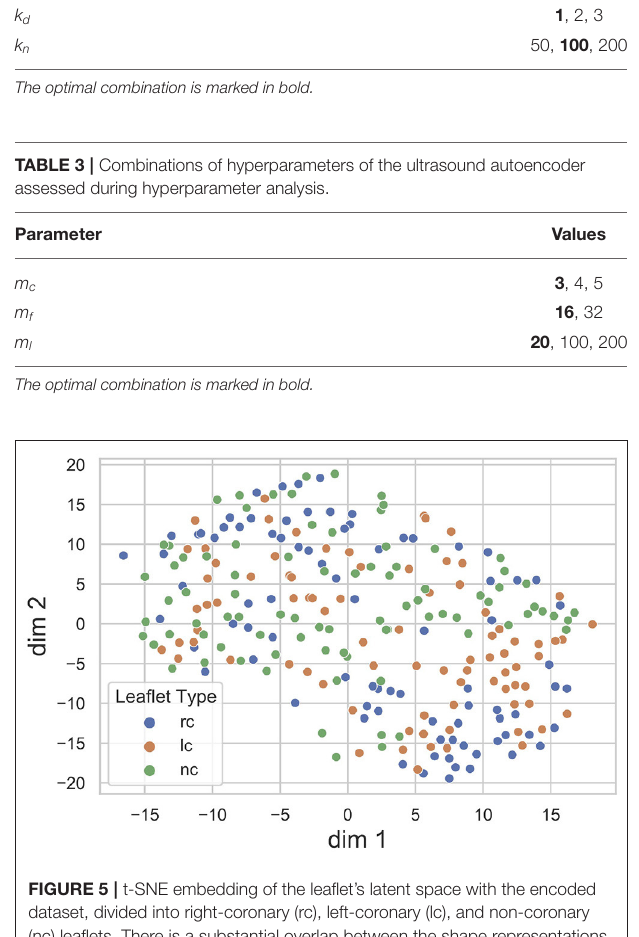
FIGURE 5 | t-SNE embedding of the leaflet’s latent space with the encoded dataset, divided into right-coronary (rc), left-coronary (lc), and